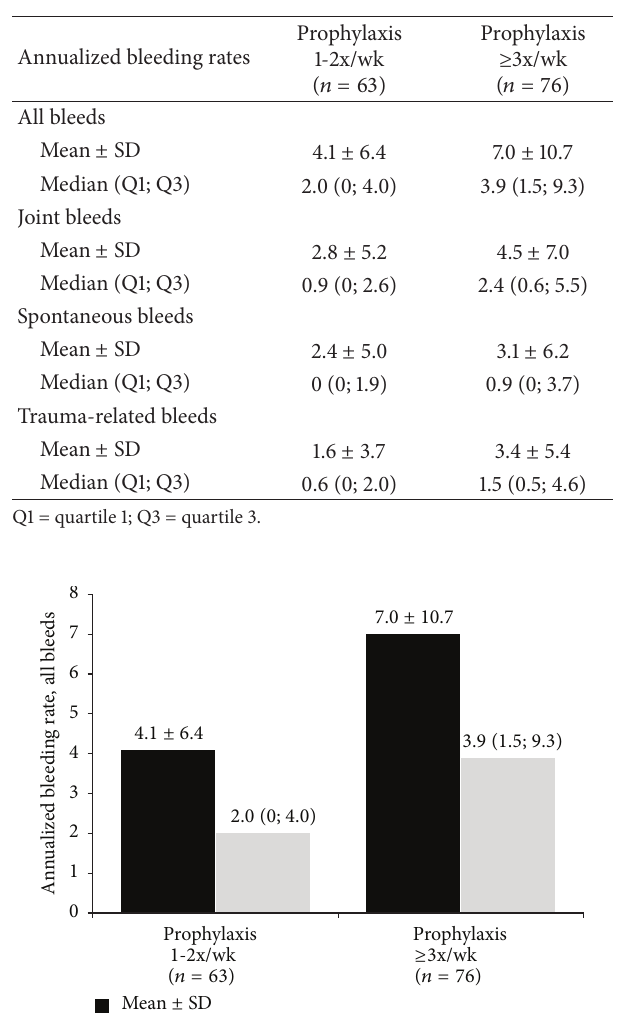
Table 2: Annualized bleeding rates by dosing group.